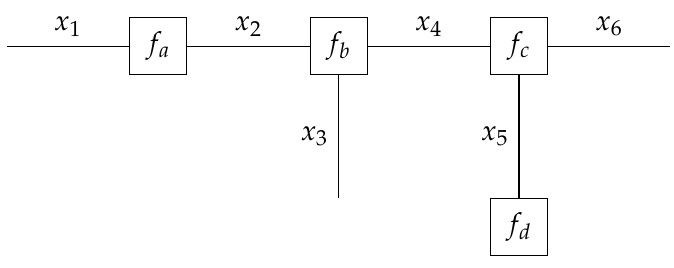
Figure 4. Forney-style factor graph representation of (17).